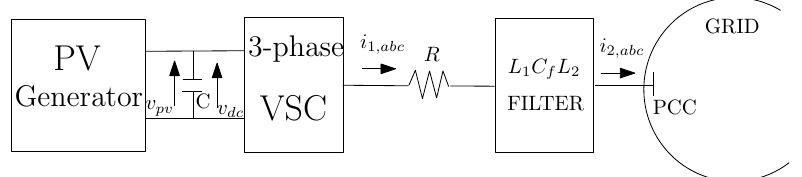
Figure 2. Schematic diagram of a PV system connected to the